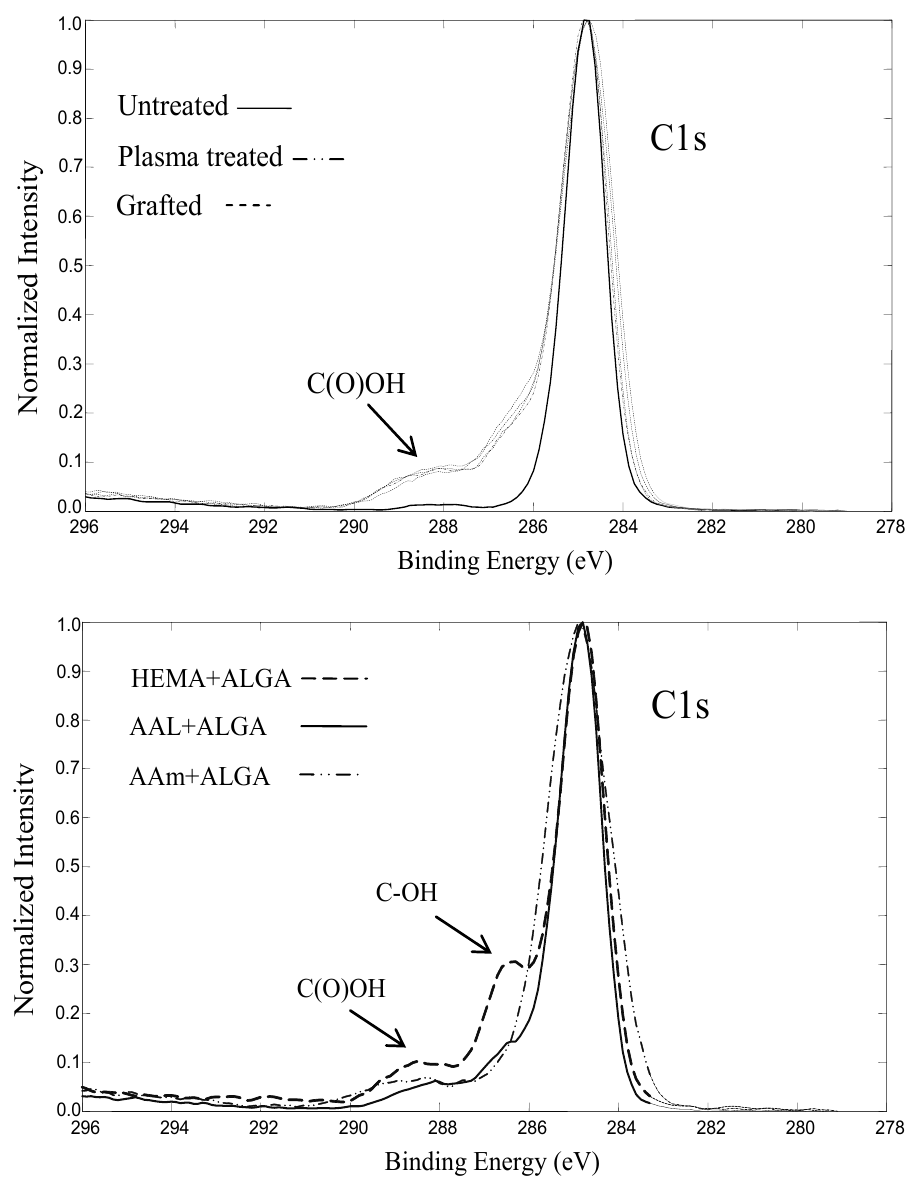
Figure 3. High resolution C1s peaks of samples 1–5 ( top ) and 6–8 ( bottom ) obtained from XPS